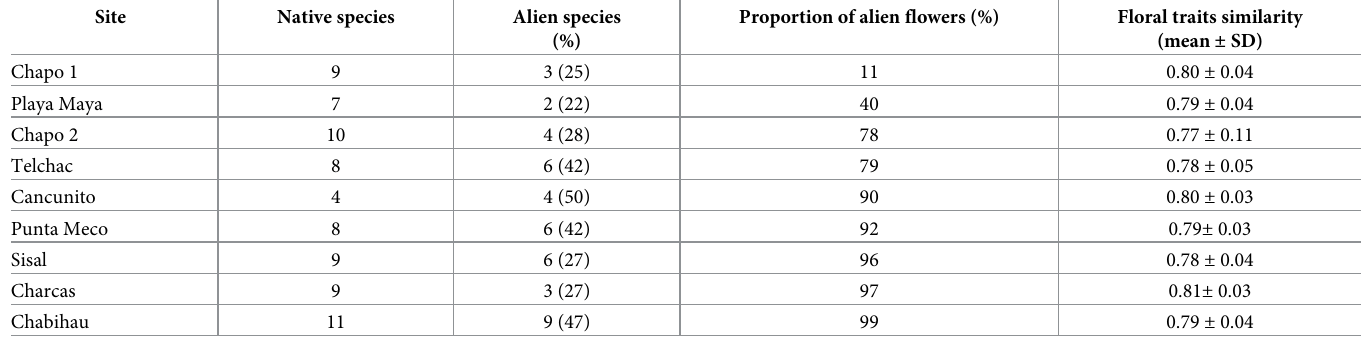
Table 1. Names of study sites. The number of native and alien species (percentage), proportion of alien flowers (percentage) and floral traits similarity between native and alien plant species at each site is shown. Sites are ordered according to proportion of alien flower abundance. Site Native species Alien species